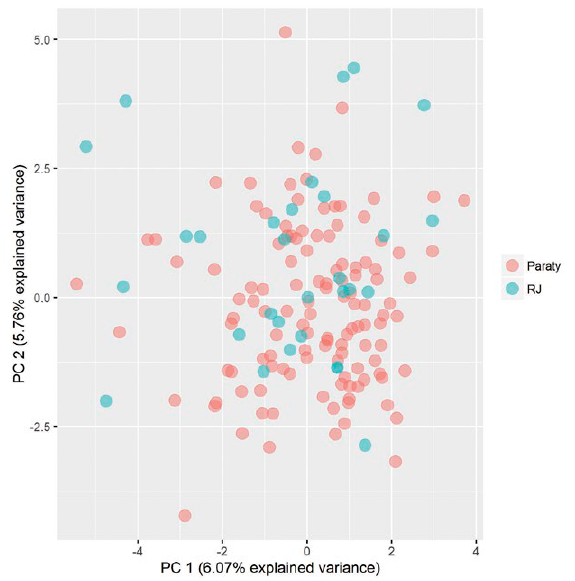
Fig. 4. – Dispersion plot of the first (PC1) and second (PC2) princi- pal components based on the analysis of 152 E. marginatus samples using 8 SSR loci. The red and blue points represent the analysed individuals from Paraty (RJ) and Rio de Janeiro (RJ),